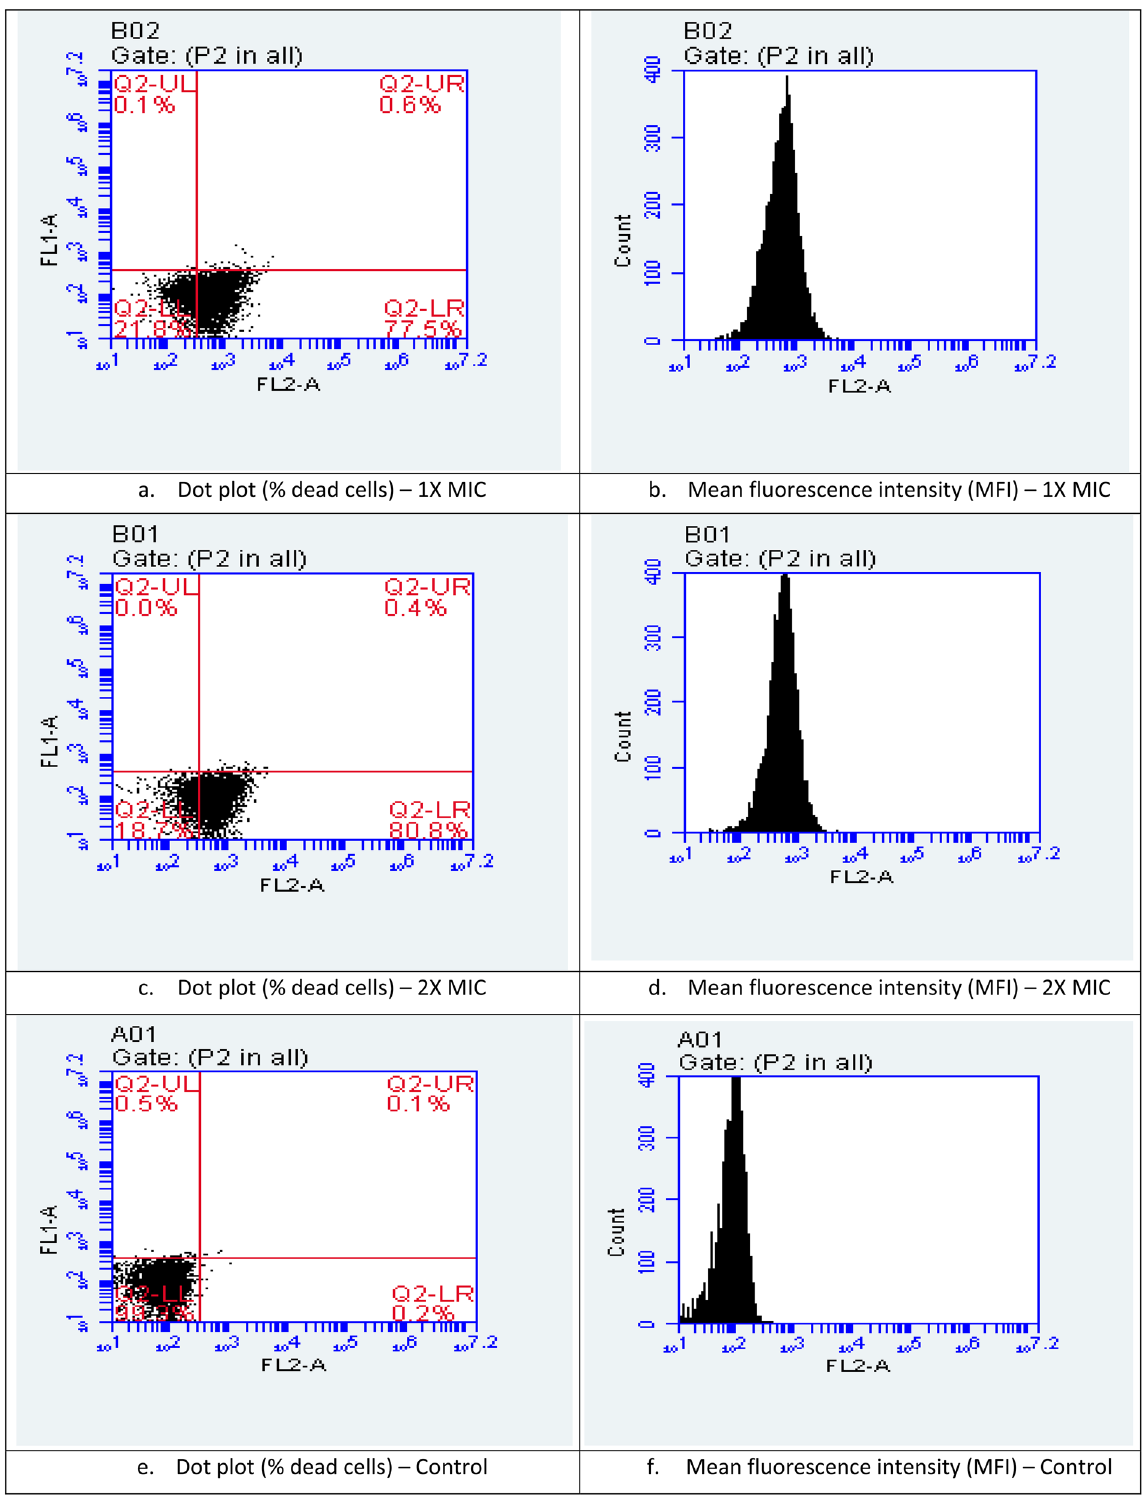
Figure 4. Membrane permeability of Escherichia coli cells at 1X MIC ( a , b ), 2X MIC ( c , d ) of Limonene, control: without limonene ( e , f